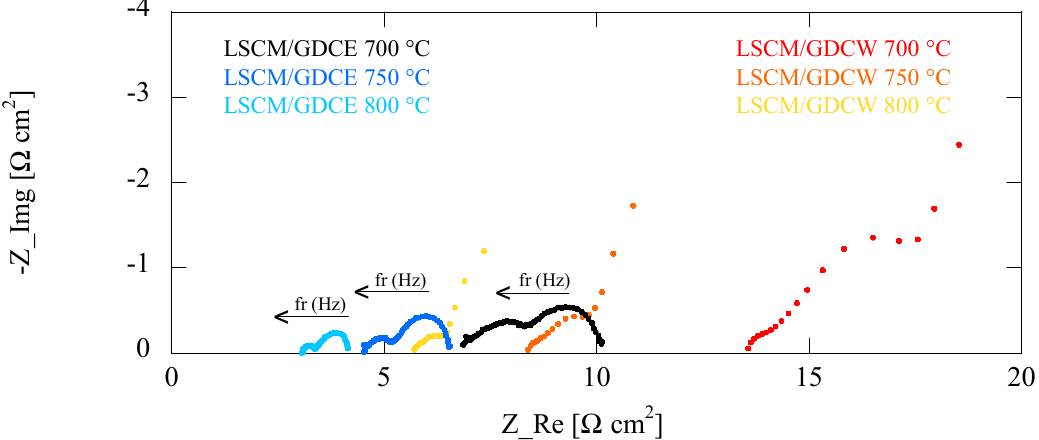
Figure 6. Nyquist plots of the LSCM / GDCW and LSCM / GDCE cells working with CO / CO 2 at di ff erent temperatures. Table 1. R ohm and R pol values of both cells operating in CO / CO 2 = 30 / 70 mixtures at di ff erent